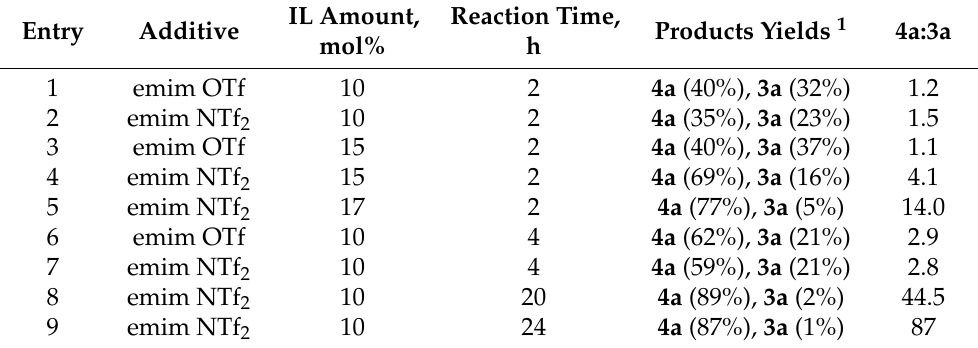
Table 2. The influence of grinding additives on the rate and selectivity of fluorination of 2-naphthol with F-TEDA-BF 4